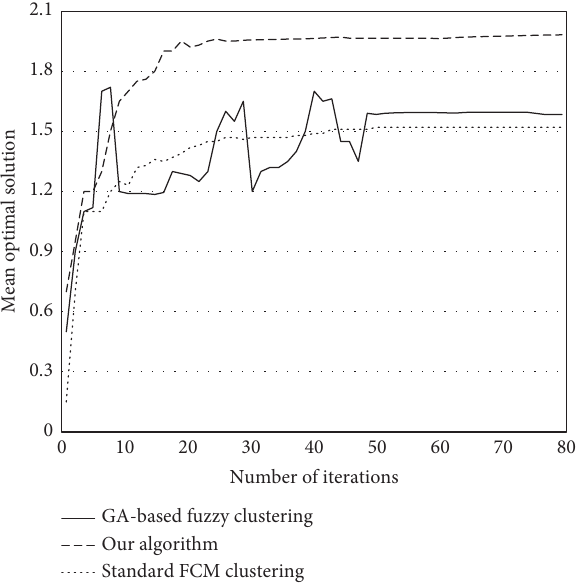
Figure 5: Curve of the mean optimal solution to the fitness of each